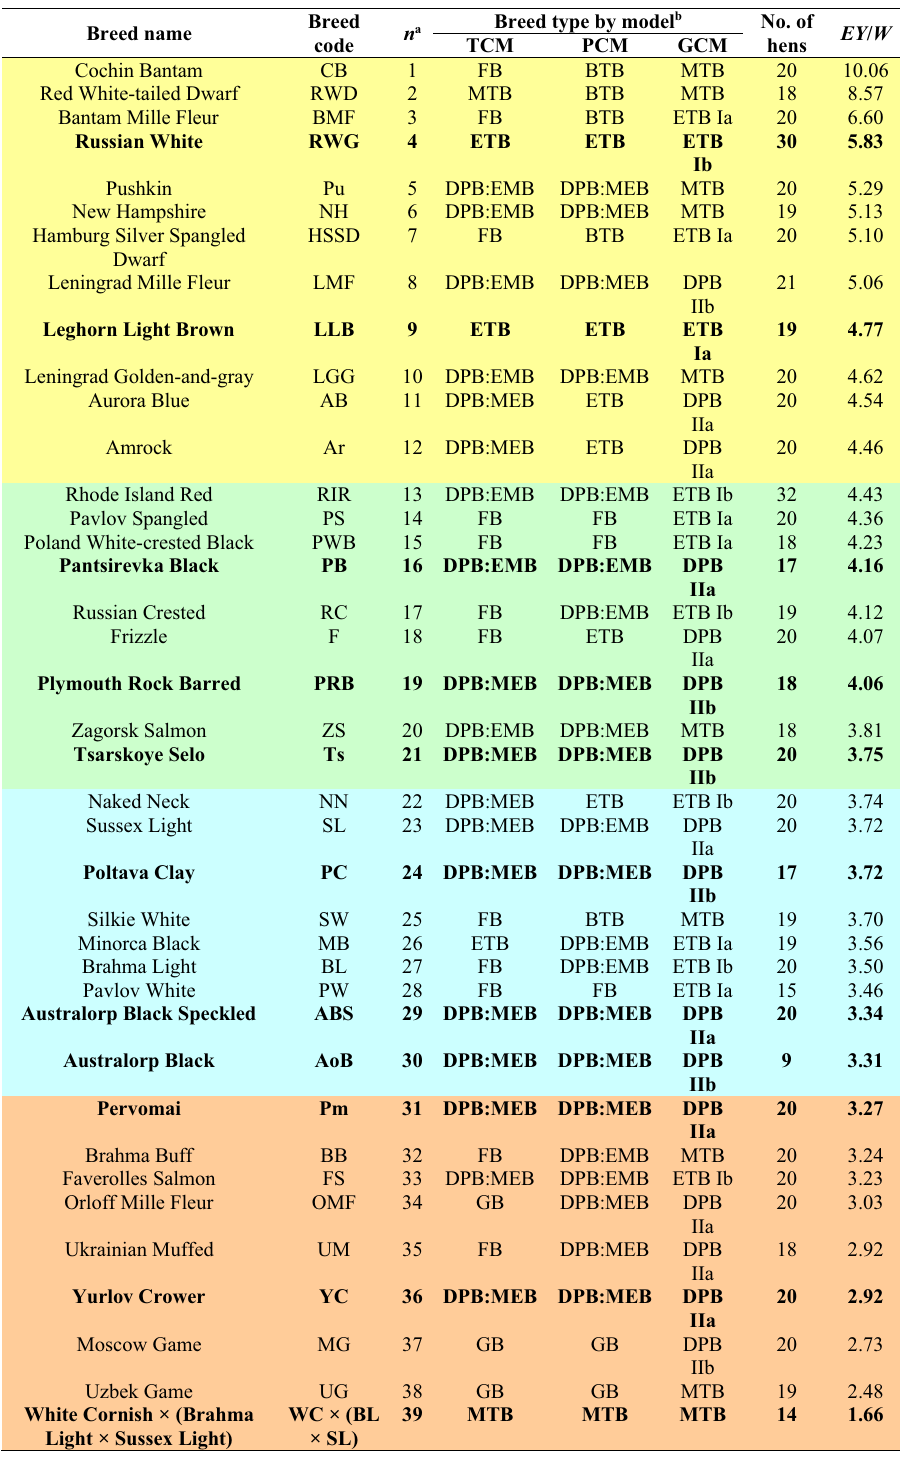
Table 1. Chicken breeds used in this study respective to breed classification (clustering) models 7 and ranked by EY / W values. a n -values are conditional serial numbers assigned to chicken breeds according to the degree of descending EY / W index. b TCM traditional classification model, PCM phenotypic clustering model, GCM genotypic clustering model. Breed types as categorized by Larkina et al. 7 : ETB egg, DPB dual purpose, EMB